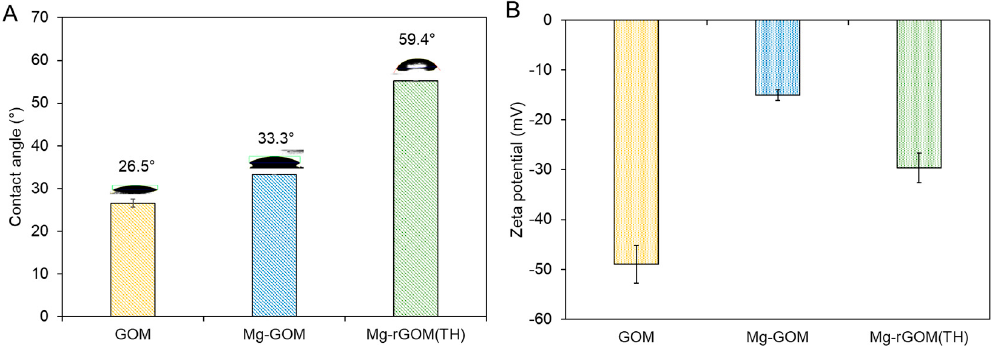
Figure 5. ( A ) Water contact angle and ( B ) surface charge of GOM